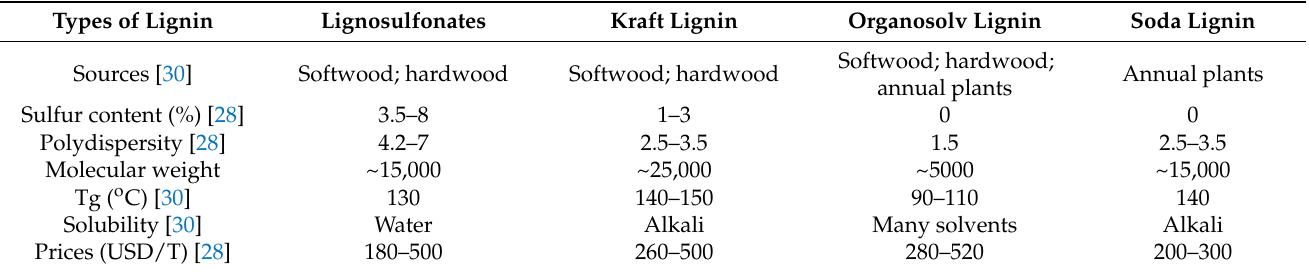
Table 1. Overview of sources, prices, and physicochemical properties of industrial lignin extracted from different